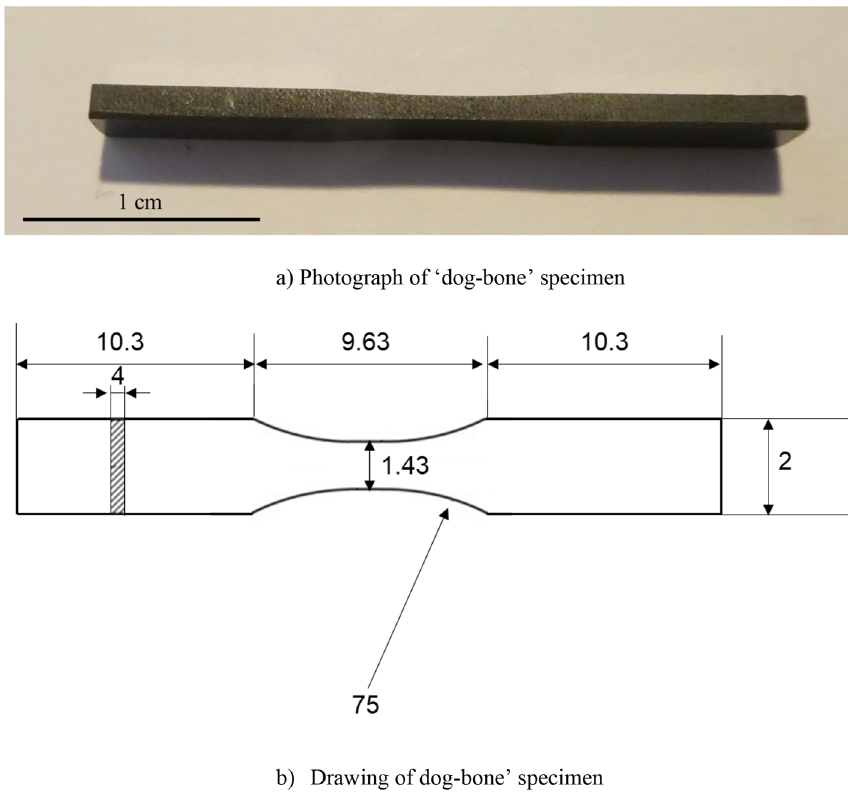
Fig. 2 a Photograph and b drawing of a typical